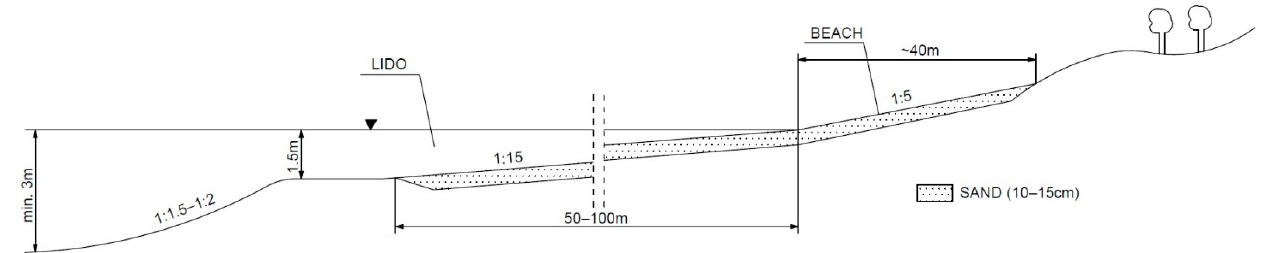
Figure 15. Profile of a lido in an old excavation of rock raw materials with the proposed new slope inclinations.